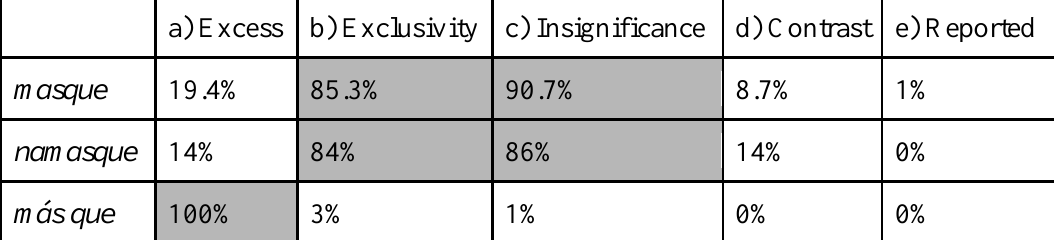
Table 2. Formal/morphological subtypes and associated